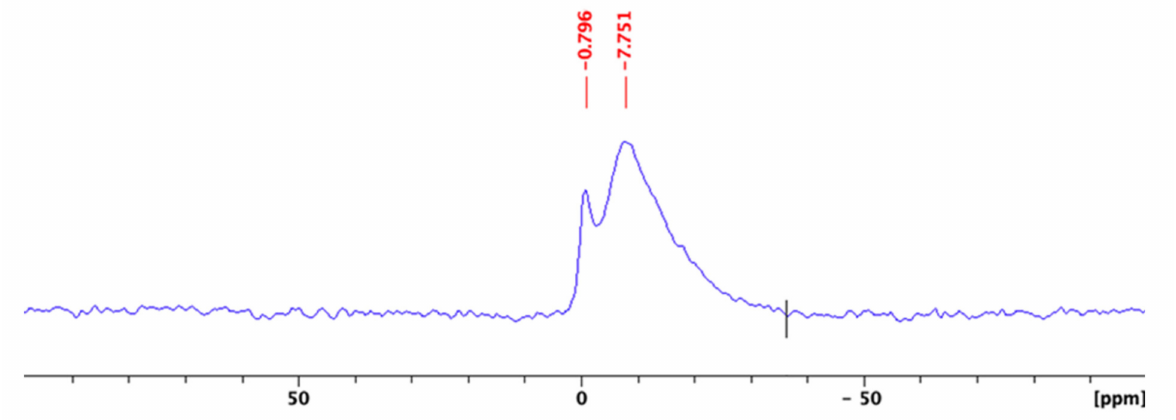
Figure 5. 23 Na MAS NMR spectrum of kraft